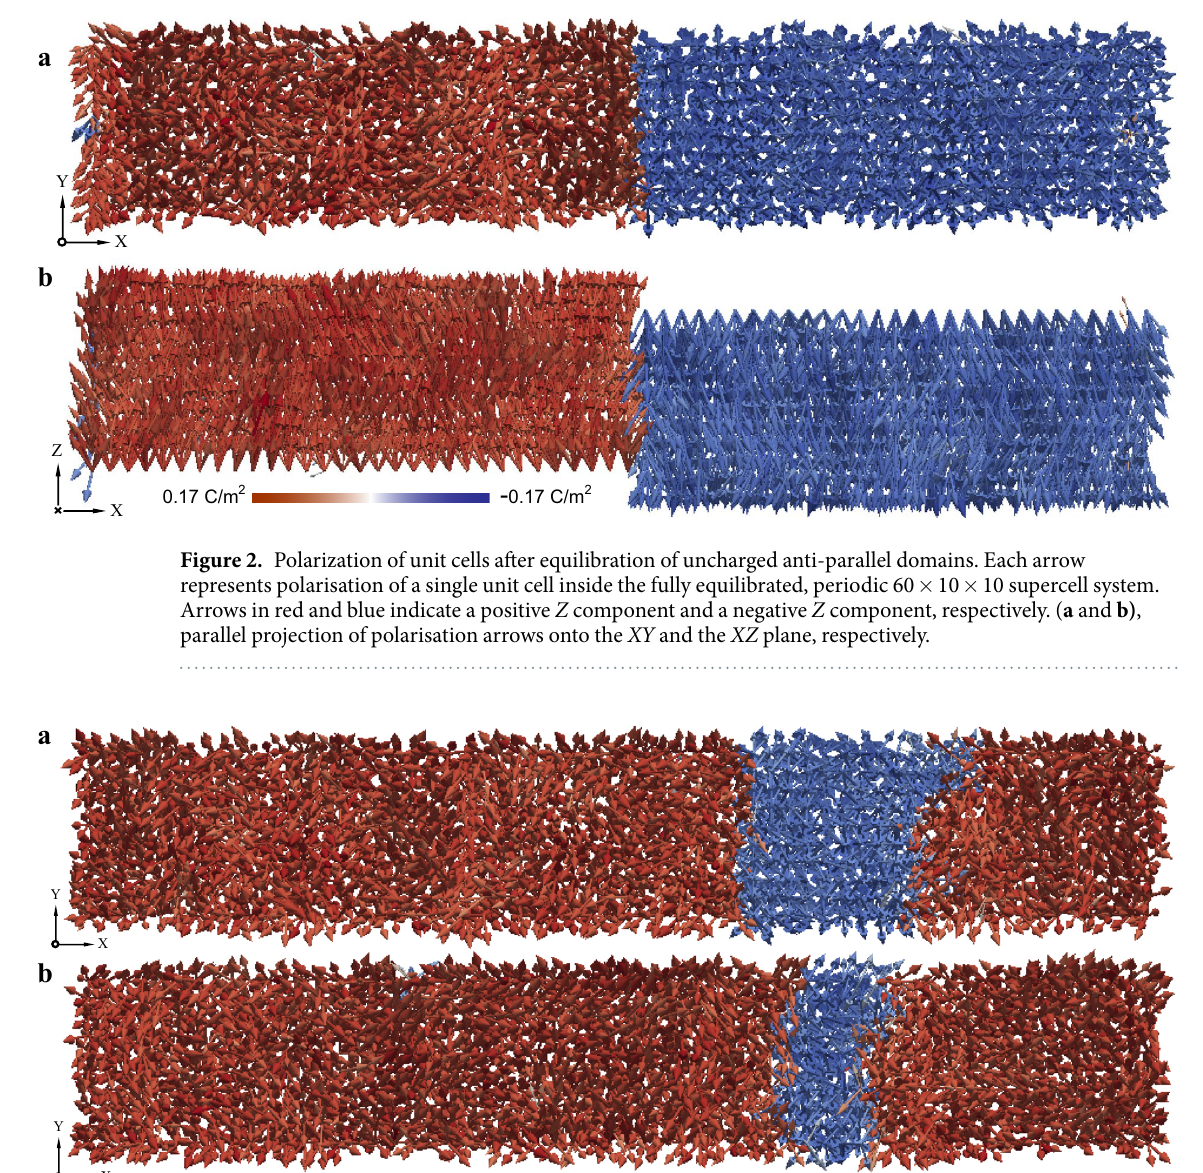
Figure 3. Domain pattern revealing propagation of domain walls. ( a ) Under an electric field of 20 MV/m, the domain patterns ( a and b ), at t = 55.4 ps and t = 77.2 ps respectively, reveal clearly that the switching process continues to be governed by the propagation of the domain walls. The domain walls approach closer to each other and merge producing a single domain after around t = 89 ps (not shown in the